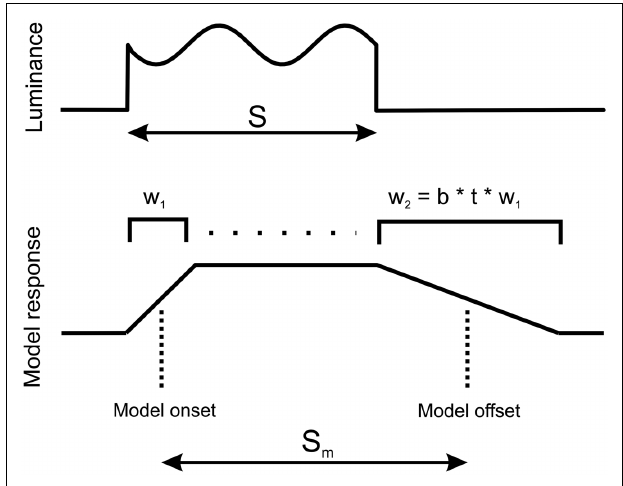
FIGURE 5 | Model of duration measurement. Luminance of the stimulus (top) is integrated using a window whose duration w i is a function of time and stimulus modulation. At stimulus onset, window length is w 1 , which then increases toward length w 2 at stimulus offset (as explained in the main text).The onset and offset of model response are estimated at the half of the maximal value of model response (bottom). S and S m are the durations of the stimulus and model response, respectively. Since stimulus offset is estimated using a longer window than stimulus onset, response to stimulus offset is delayed, causing an apparent increase of stimulus duration.